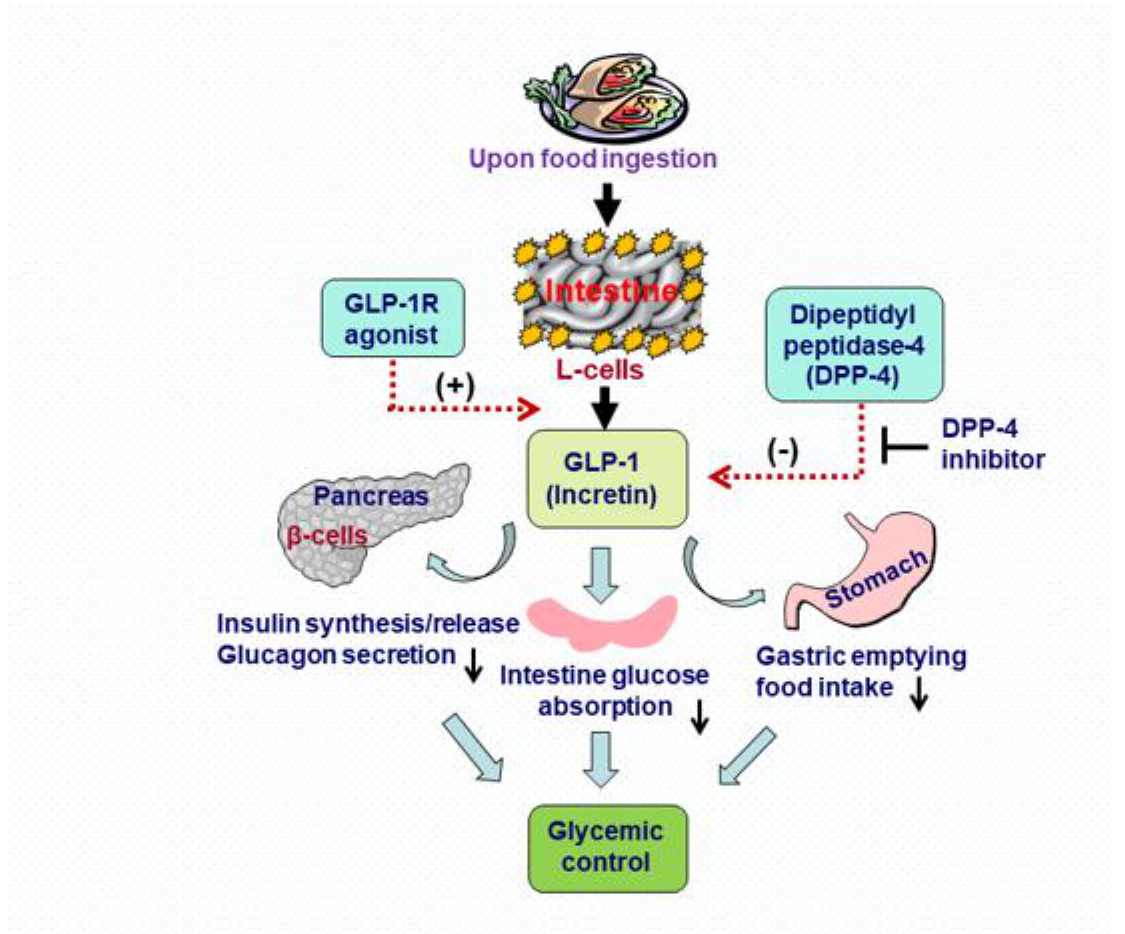
Figure 1. Glycemic control of glucagon-like peptide-1 (GLP-1). GLP-1 is an incretin glucoregulatory hormone released from the L cells of the intestine in response to food intake. When plasma glucose levels are elevated, GLP- 1 stimulates the β cells of the pancreas to release insulin, decreases gluca- gon secretion from the intestine via acting on the GLP-1 receptor, and slows gastric emptying and food intake (downward arrows). Endogenous GLP-1 is extremely susceptible to the catalytic activity